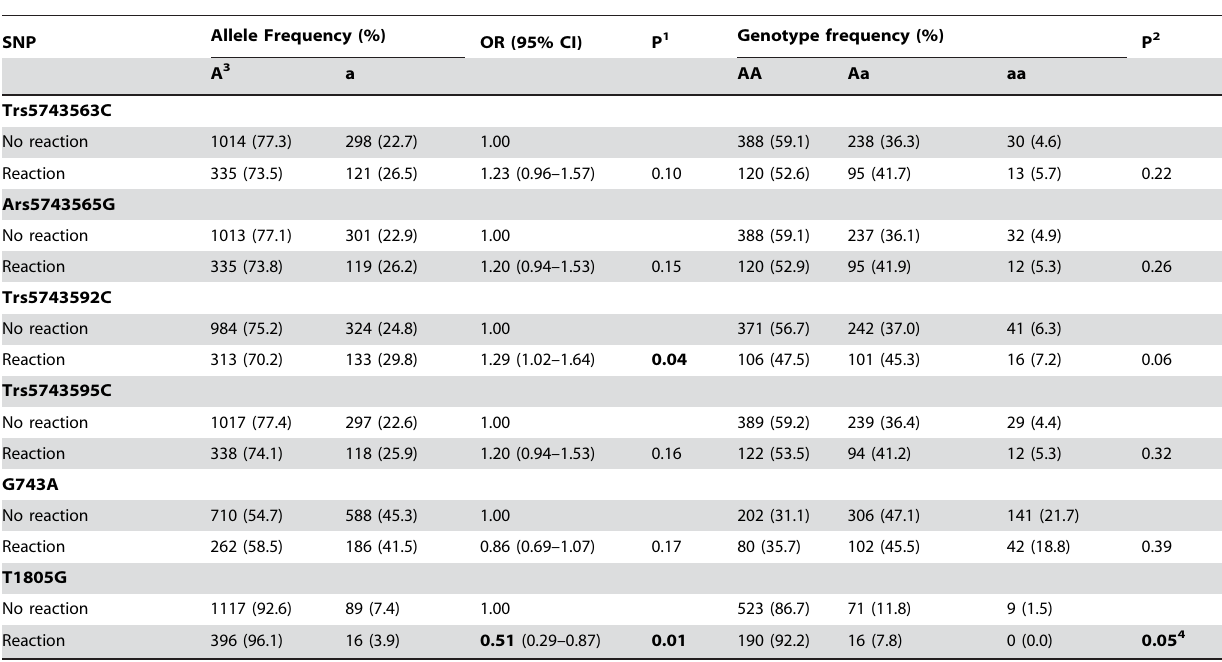
Table 3. TLR1 Polymorphism Frequency in Reversal Reaction.